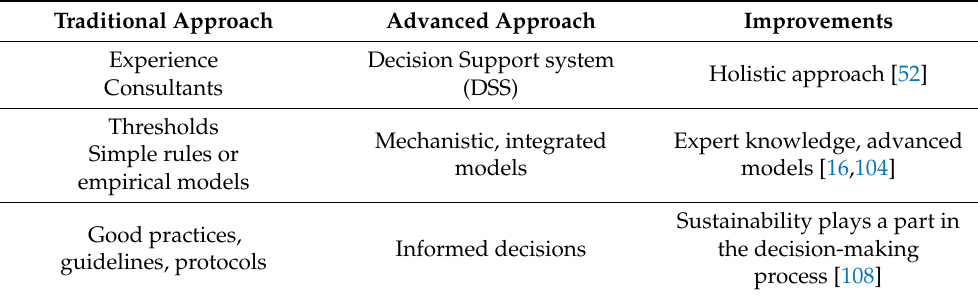
Table 3. Tools adopted for decision making in crop protection, according to the traditional approach, and possible improvements provided by a more advanced, digital-based